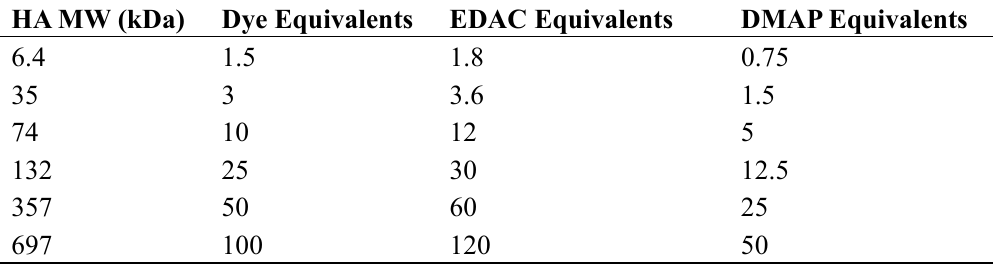
Molar equivalents of each reagent used in the conjugation of 5-carboxypentyl-amino-IR-820 (dye) to each MW of HA to form the HA-IR820 conjugates. HA MW (kDa) Dye Equivalents EDAC